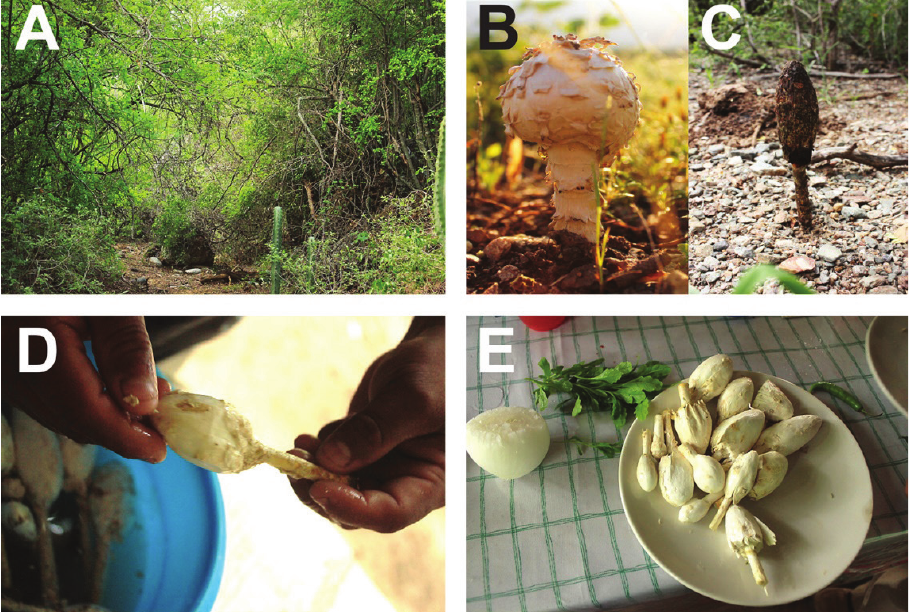
Figure 5. A Desert scrub B Immature state of Podaxis sp. (MEXU 27843) and C at maturity (the gleba changes from white to dark brown (MEXU 27844); Culinary preparation: D cleaning process of the fruiting body of Podaxis sp. and E mixing ingredients for the typical dish [onions, “epazote” ( Dysphania ambrosioides ) and green pepper (chile